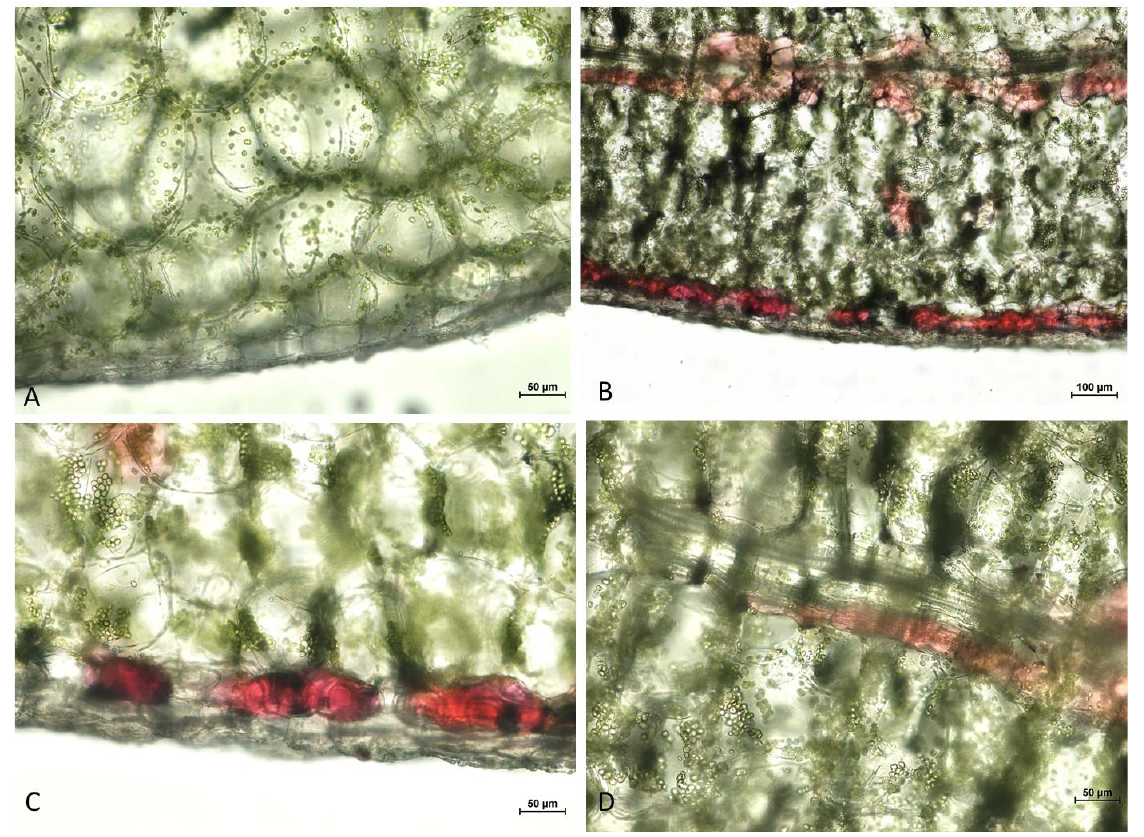
Figure 11. Freehand cross-section of K. blossfeldiana leaves indicating local occurrence of anthocyanins. ( A – C ) Lower/Abaxial part of the leaf blade. ( A ) control — day 0 after leaf detachment. ( B – D ) Detached leaves were kept for 4 days in an inverted position in natural light conditions. ( B , C ) Local accumulation of anthocyanins in sub-epidermal mesophyll cells. ( B , D ) Occurrence of anthocyanins in mesophyll cells of the vascular bundle.